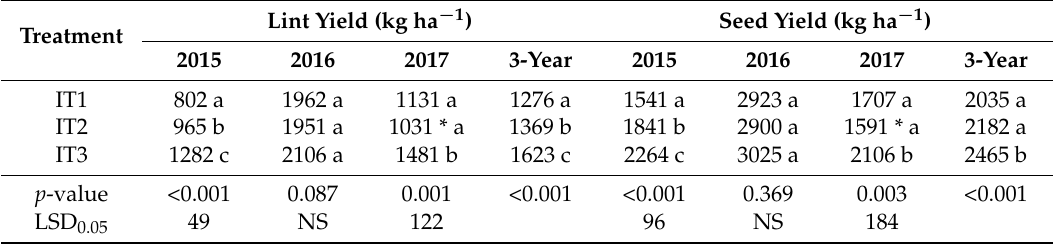
Table 5. Lint and seed yields for all treatments and years. Means followed by the same letter are not significantly different within years, at a 0.05 significance level according to the least significant difference